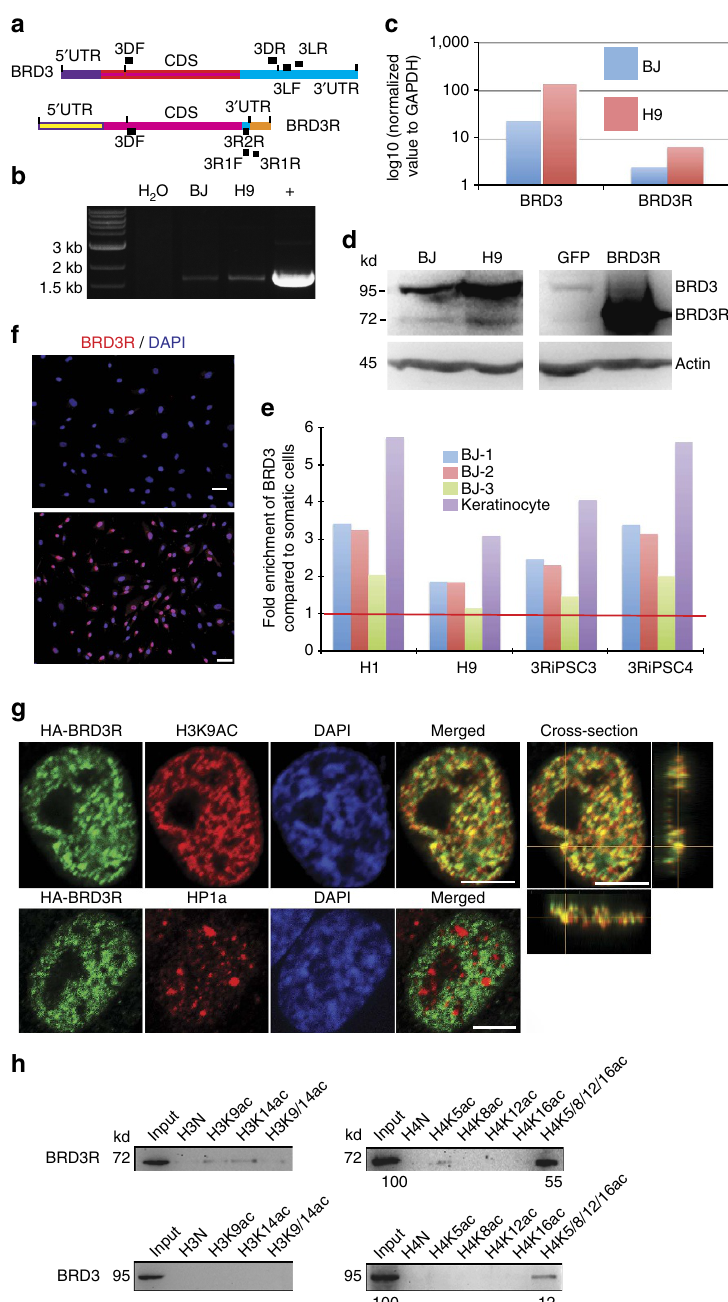
Figure 4 | Expression and euchromatin binding of BRD3R in human cells. ( a ) cDNA structure and primer locations of BRD3R in comparison with its long isoform BRD3. magenta box, identical cDNA regions. Primer locations are indicated by black boxes with primer name by their side. F in primer name, forward primers; R in primer name, reverse primers. Primer sequences are listed in Supplementary Table 3. ( b ) Semiquantitative RT–PCR with BRD3R-specific primers, demonstrating a higher expression level in hESCs (H9) than in somatic cells (BJ). þ , Positive control with BRD3R plasmid as PCR template; H 2 O, control without template. ( c ) RT–qPCR quantification of BRD3R and BRD3 expression in H9 cells in comparison with that in BJ cells (mean ± s.d., n ¼ 3). Expressions are normalized to GAPDH and presented as Log scales. ( d ) Western analysis of BRD3R/BRD3 protein. Left panel, protein samples from naive BJ and H9 cells; right panel, protein samples from BJ cells transduced with GFP (left) and BRD3R lentiviruses (right); the lower parts are b -actin loading control. ( e ) Fold enrichment of BRD3R/BRD3 mRNA in human PSCs as compared with somatic cells calculated from RNA-seq data of three